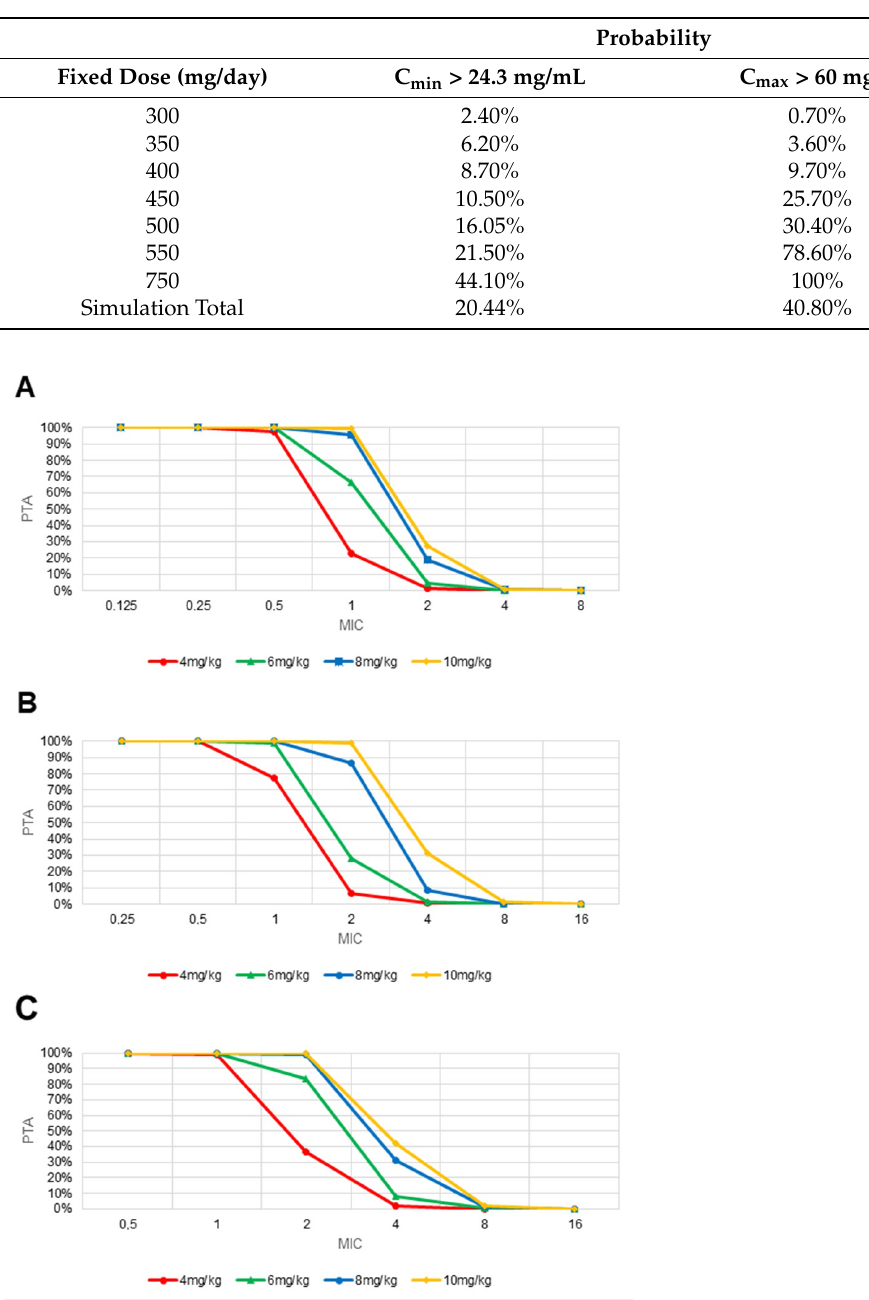
Table 4. Probability of overcoming the tolerability and efficacy cut-off values (24.3 mg/L and 60 mg/L, respectively), calculated on the 10,000 simulated patients.